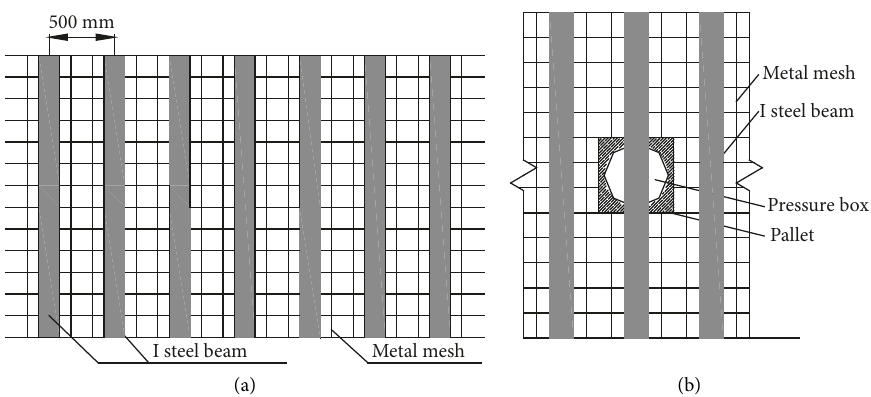
Figure 14: Design of gangue retaining support and pressure detection. (a) Gangue wall maintenance support design. (b) Gangue wall pressure monitoring